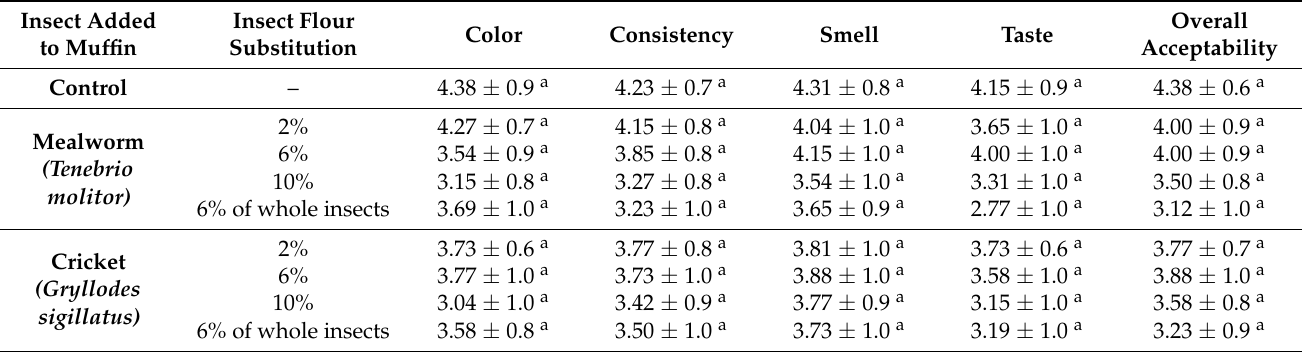
Table 4. Consumer acceptance analysis of